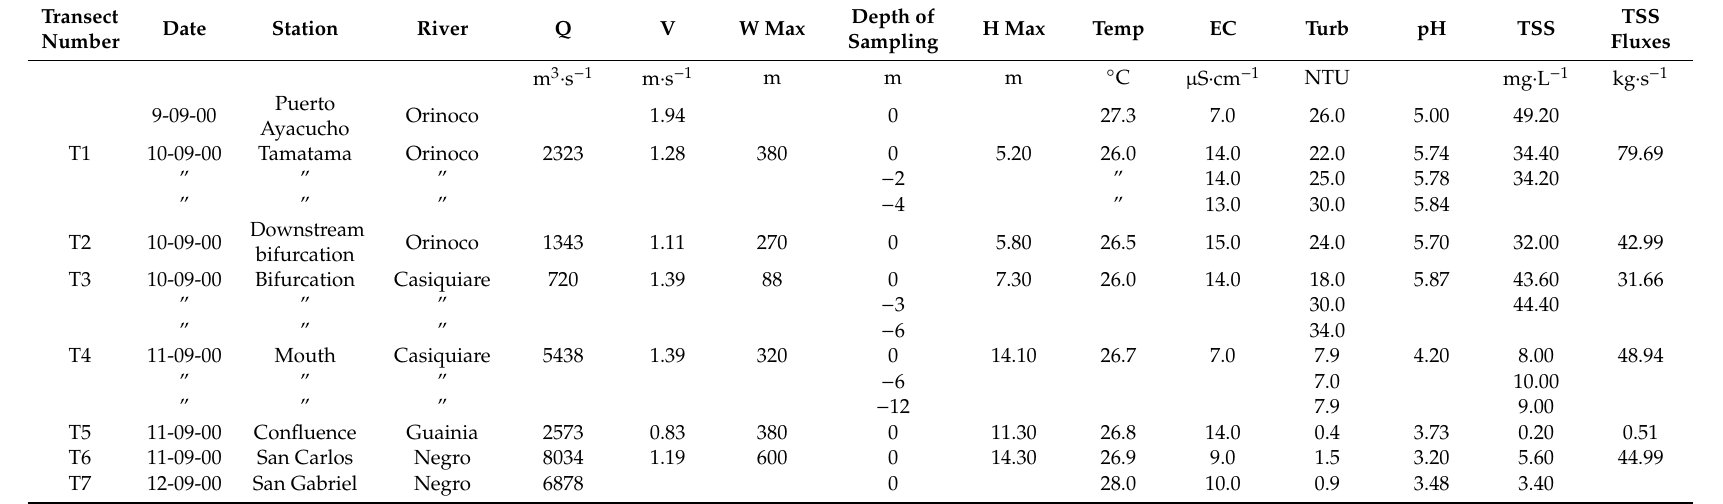
Table 1. Hydrologic and physico-chemical data obtained from measurements at the bifurcation and confluence of the Casiquiare Channel in September 2000. Q = flow discharge; V = surface flow velocity; W max = maximum channel width; H max = maximum depth; Temp. = temperature; EC = electrical conductivity; Turb = turbidity; TSS = total suspended sediment